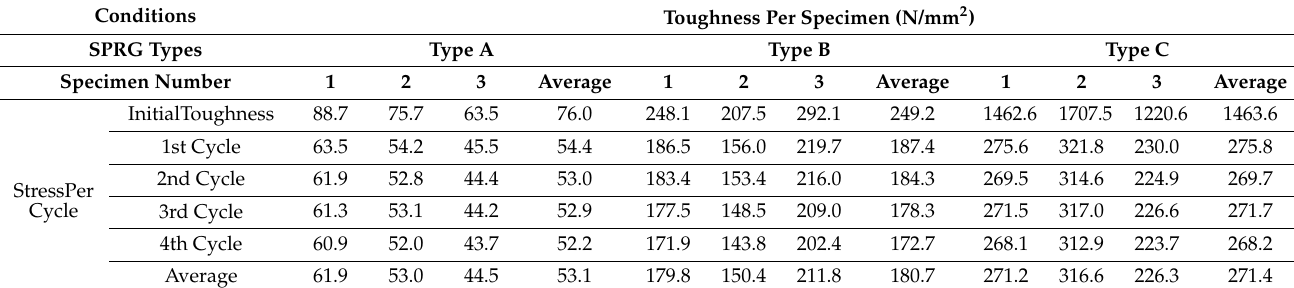
Table 7. Toughness calculation—Load (N/mm 2 ), Displacement (mm). Refer to Table 7 below for results on toughness calculation results based on the repeated tensile stress testing.